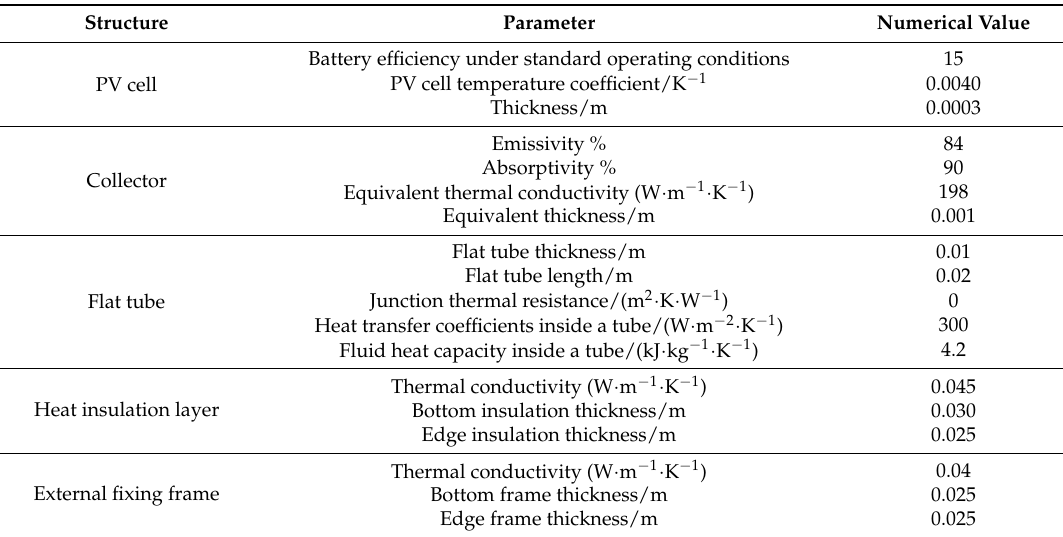
Table 4. Structural parameters of the solar building